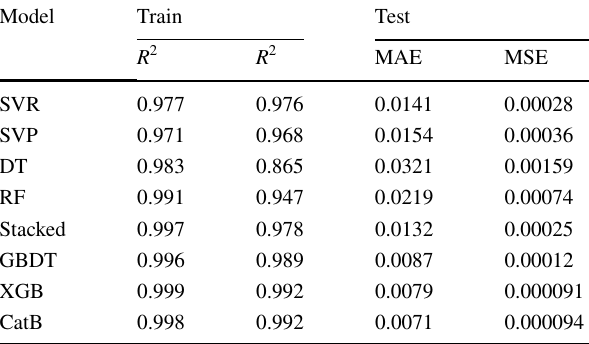
Table 4 Accuracy metrics of different algorithms in estimation of C Model